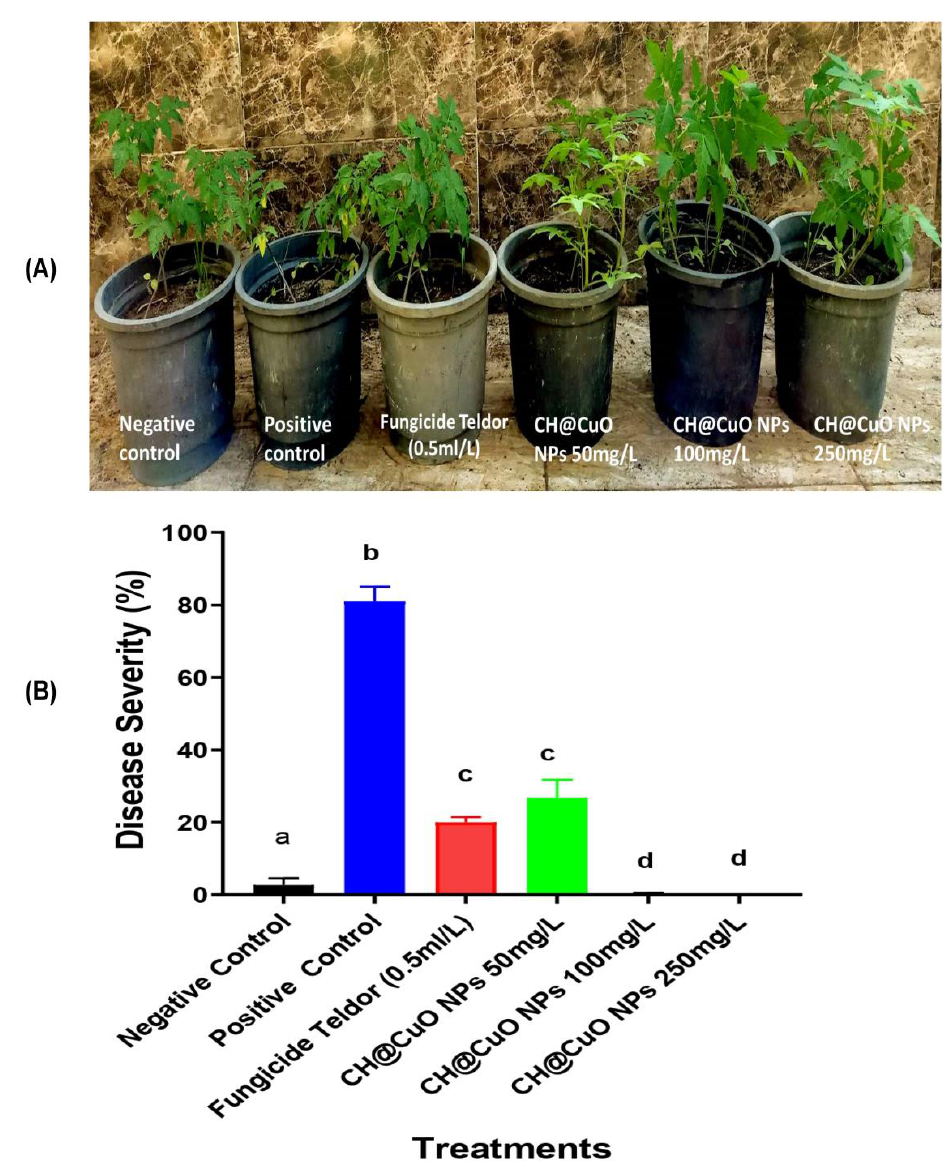
Figure 7. Gray mold disease severity on leaves of whole tomato plants in response to treatment with CH@CuO NPs at concentrations 50, 100 and 250 mg/L and Teldor 50% SC ( A , B ). Bars with the same letters are not statistically significant based on the LSD test ( p < 0.05).